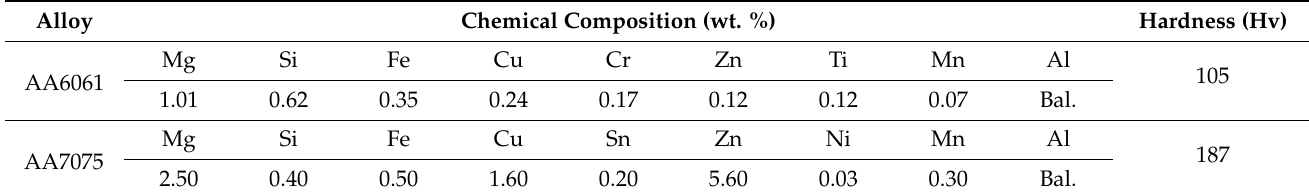
Table 1. Chemical composition and hardness of base materials used in this study. Alloy Chemical Composition (wt. %)